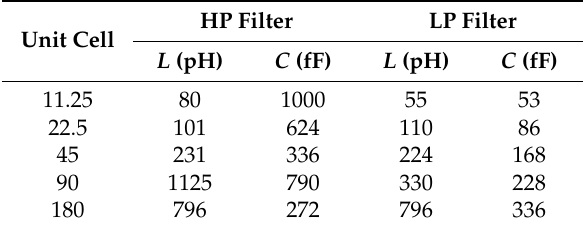
Table 2. The real values of the L and C elements used in the design of phase shifter.